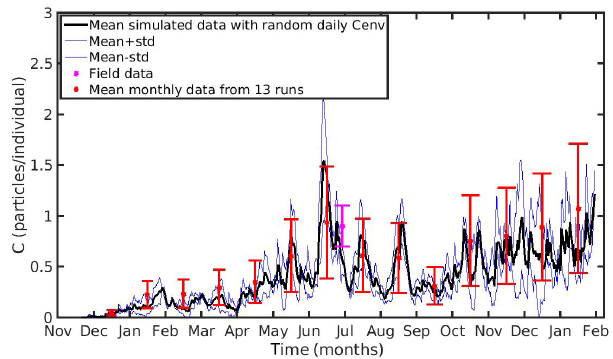
Figure 10. Mean monthly values and standard deviation of mi- croplastics accumulation (red error bars: mean value ± SD) by the mussel in northern Ionian Sea derived from 13 model runs with different constant values of environmental MPs concentration ( C env range: 0.0012–0.024particlesL − 1 ); Mean hourly simulated data (back line) and standard deviation (blue lines) of microplas- tics accumulation derived from three model runs with stochastic se- quences of daily random C env